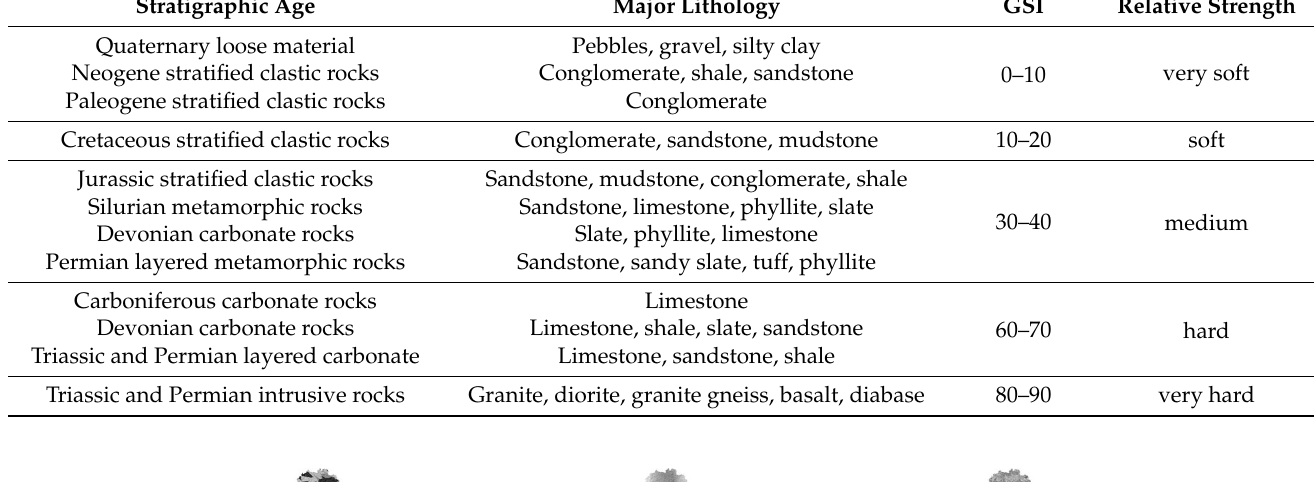
Table 1. Lithologies in the study area and their hardness classification.